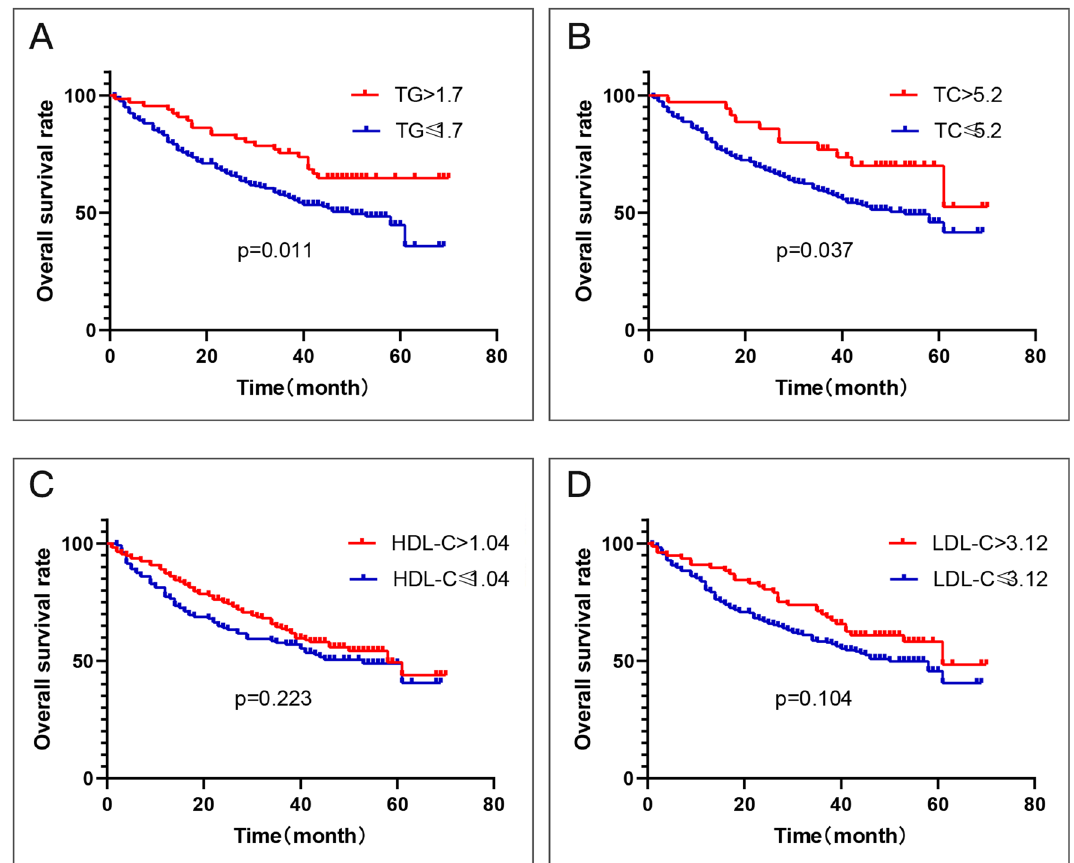
Figure 1. Kaplan–Meier curve for overall survival regarding low vs high TG levels (P = 0.006) ( A ); low vs high TC levels (P = 0.008) ( B ); low vs high HDL-C levels (P = 0.169) ( C ); low vs high LDL-C levels (P = 0.177) ( D